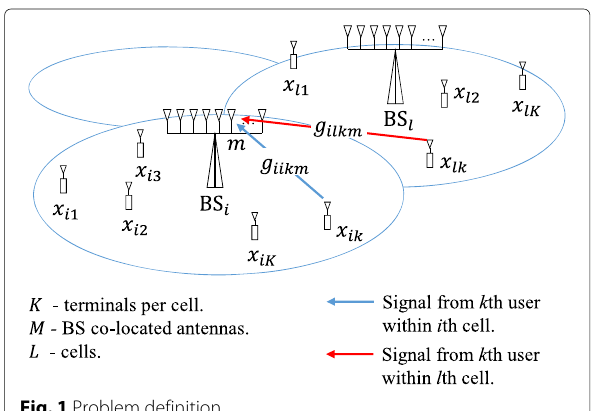
Fig. 2 TDD transmission